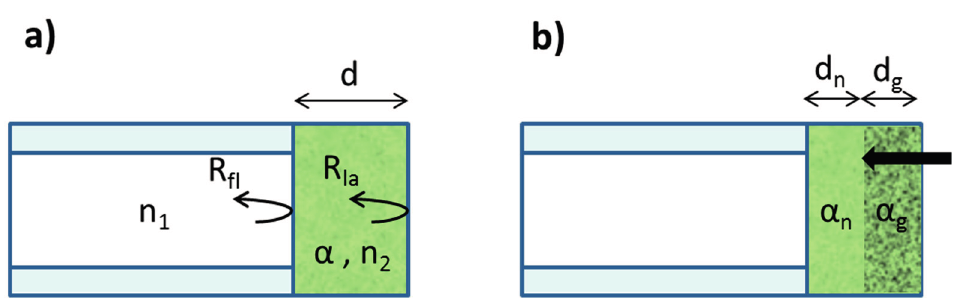
Figure 8. Sensor representation ( a ) before and ( b ) after NO 2